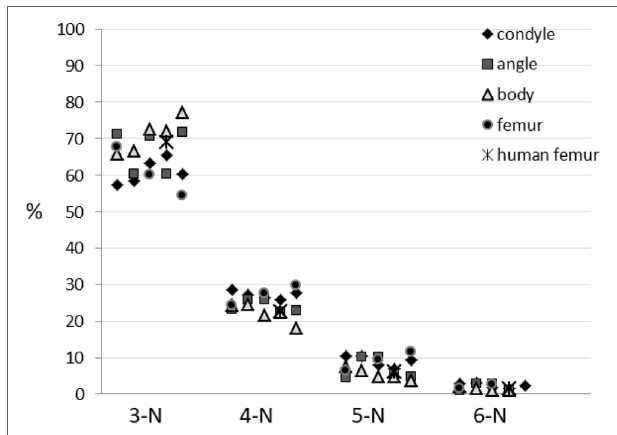
FigUre 5 | Abundances of different nodes types in the examined areas of the pig mandibular condyle (five specimens), mandibular angle (five specimens), mandibular body (five specimens), pig proximal femur (three specimens) and human proximal femur [average of five specimens is taken from Reznikov et al.